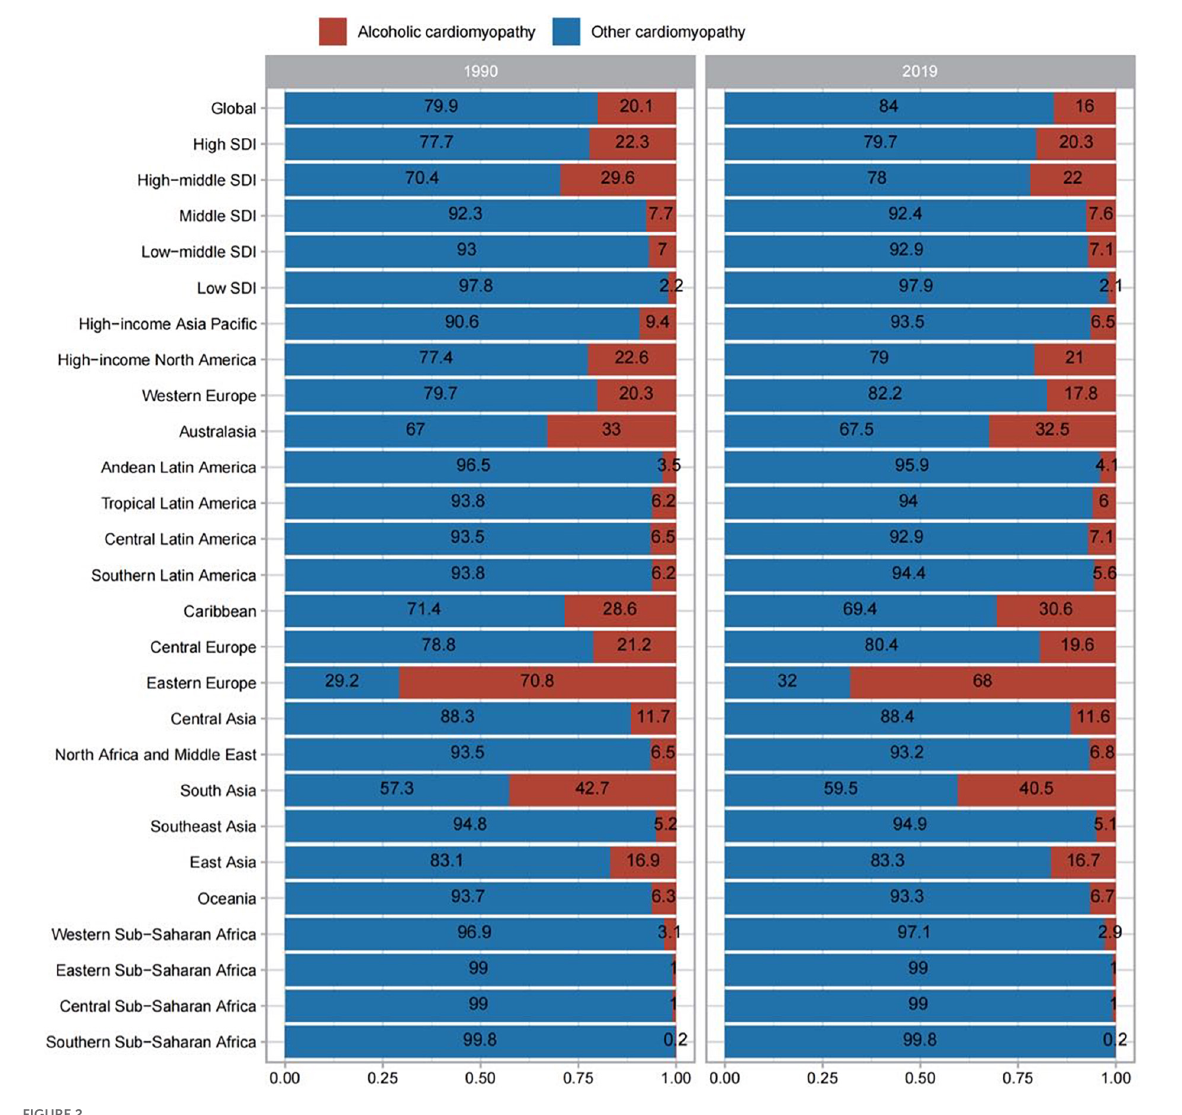
In line with the above data, age-standardized AC and OC mortality rates declined by − 0.36% (95% UI: − 0.5 to −